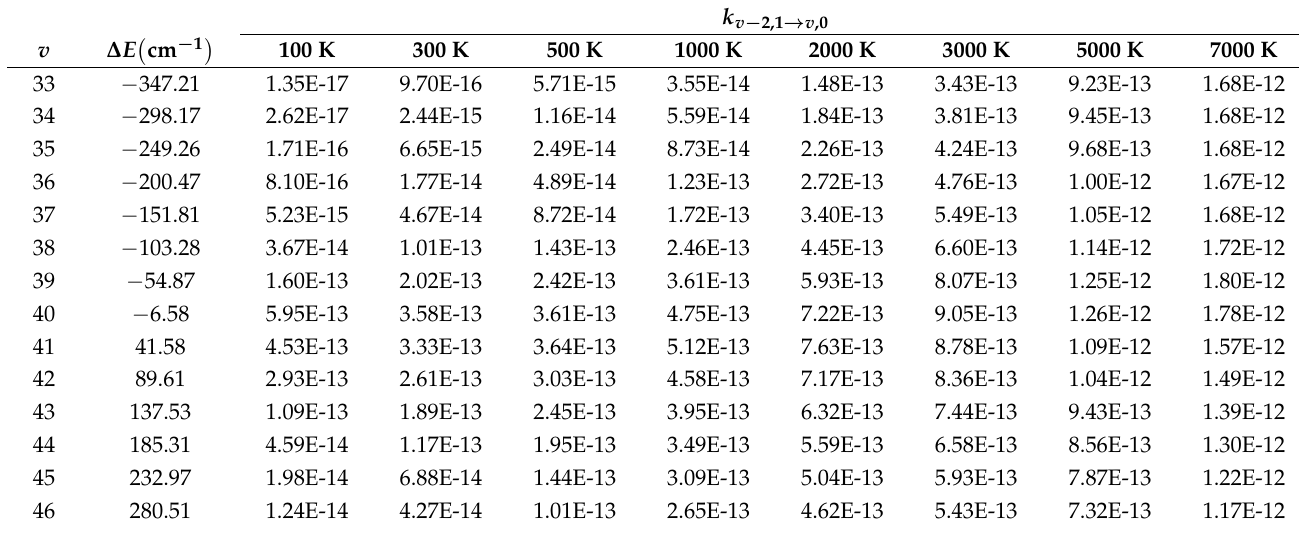
Table 6. V–V rate coefficients (in cm 3 /s) for the near-resonant asymmetric transition CO ( v − 2 ) + N 2 ( 1 ) → CO ( v ) + N 2 ( 0 ) + ∆ E .